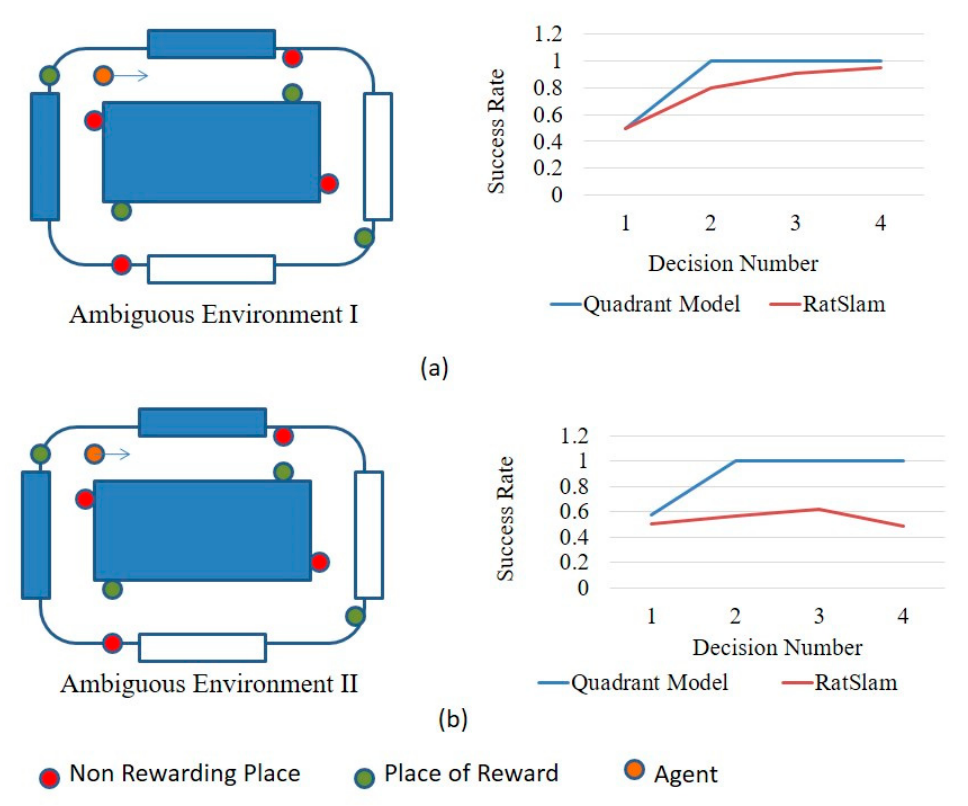
Figure 26. Localization in an ambiguous environment.